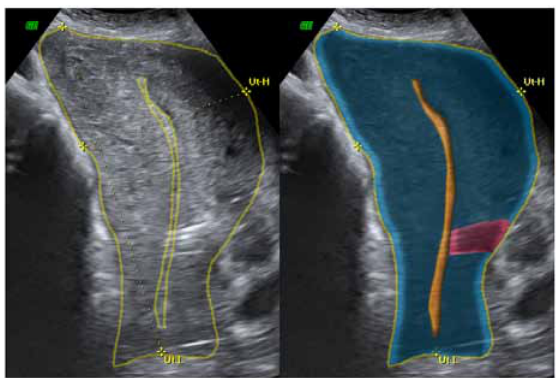
Figure 1. Sagittal view of the uterus with highlighted margins obtained transabdominaly 48 hours after CS. Ut-H, uterine height; Ut-L, uterine length. Blue – myometrium. Purple – scar.